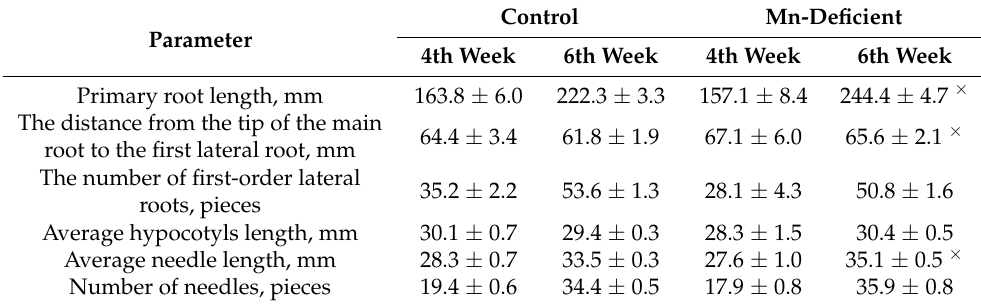
Table 2. Growth parameters of Scots pine seedlings at the 4th and 6th weeks of the experiment. Parameter